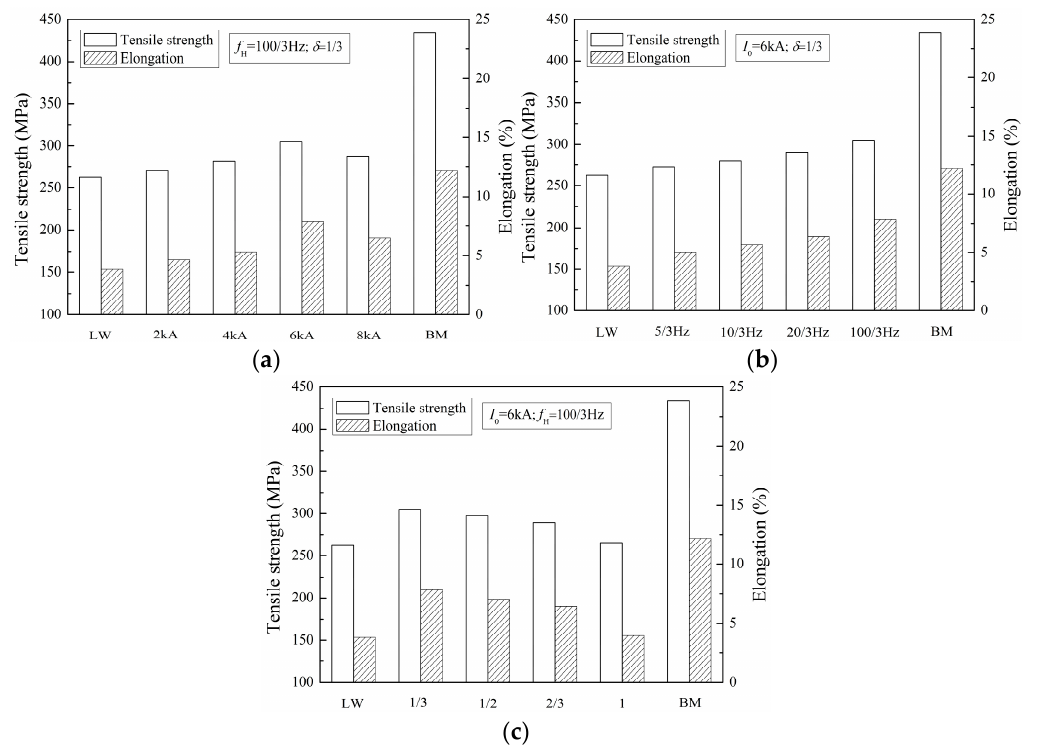
Figure 13. Tensile properties of welded joints with ( a ) different peak current I 0 ; ( b ) different pulse frequency f H ; and ( c ) different pulse duty ratio δ .